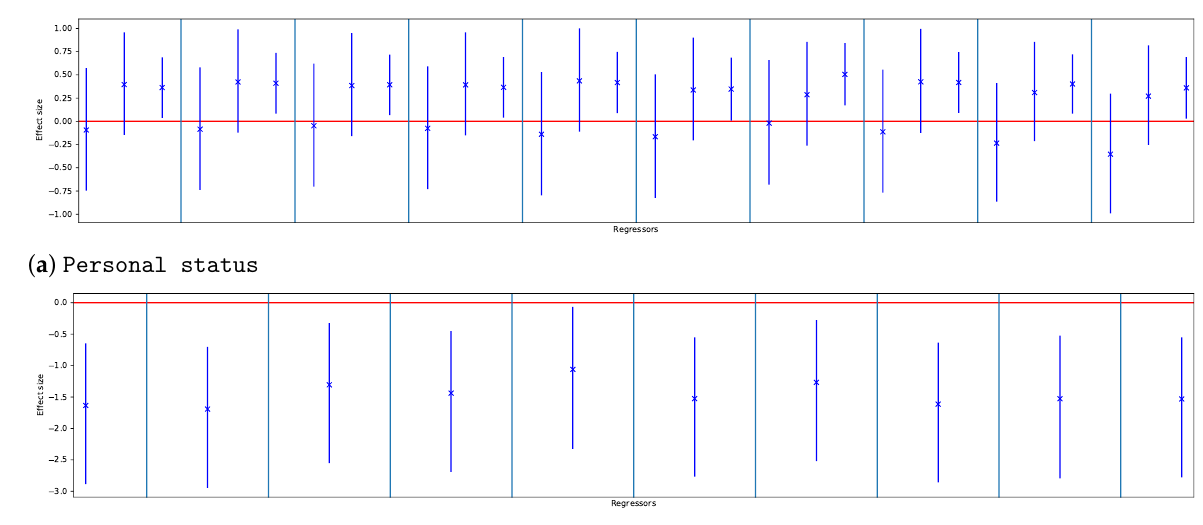
Figure 9. Zoom on the first models containing Personal status ( a ) and Foreign worker ( b ) in the experiment with support 0.09 and confidence